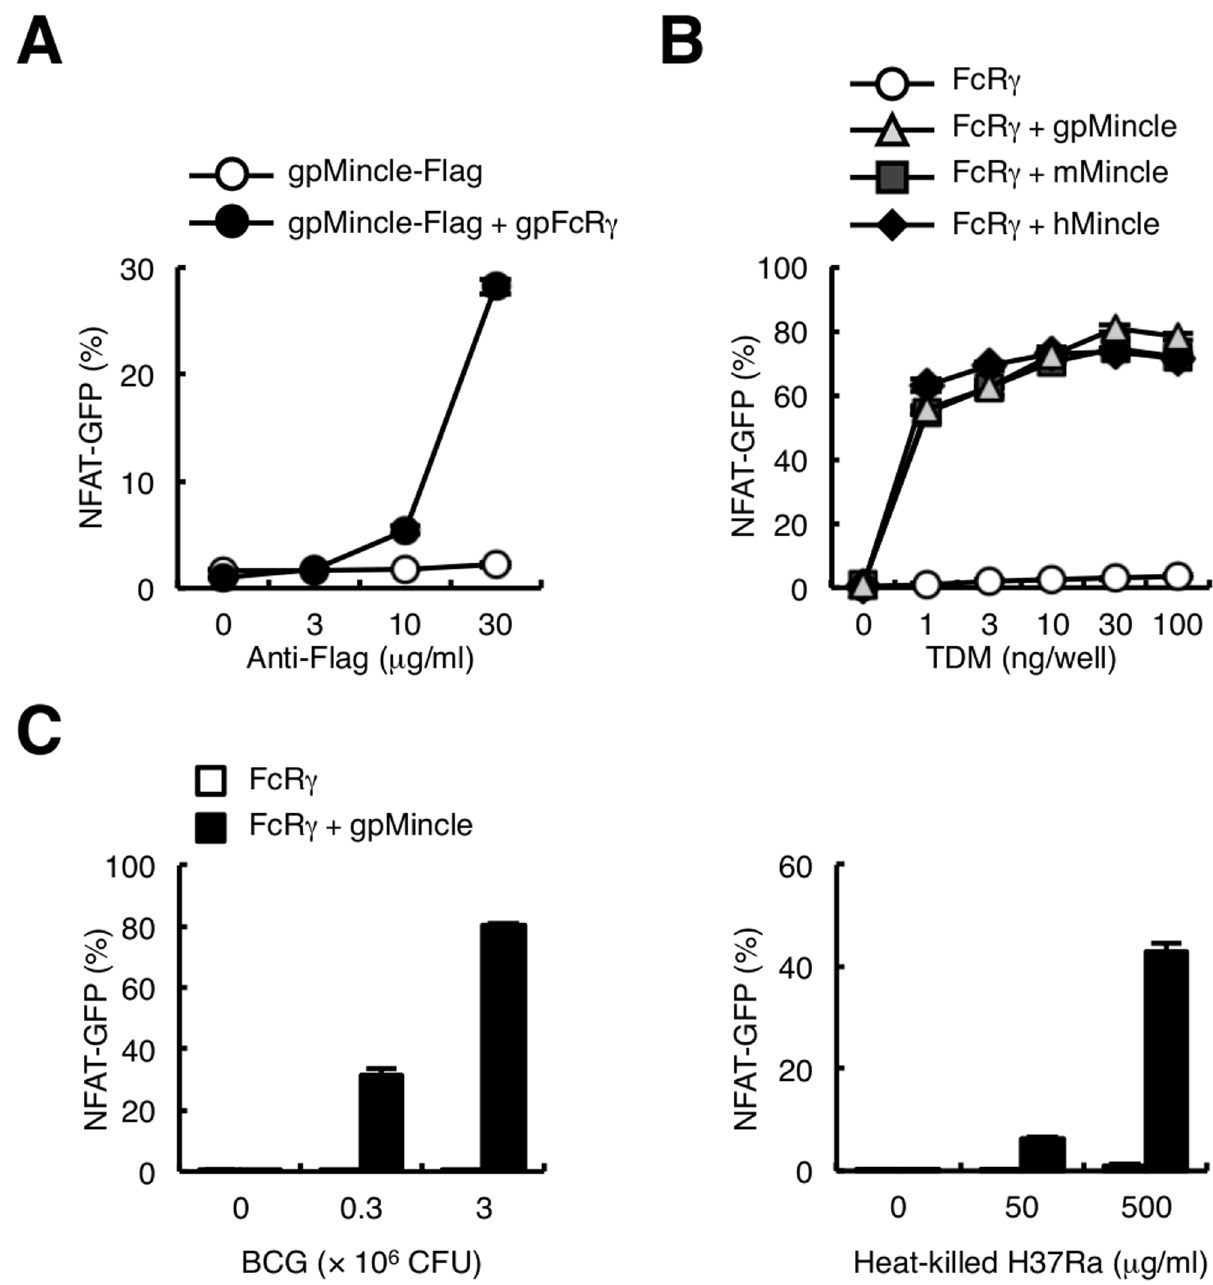
Figure 4. gpMincle functions as an activating receptor for TDM. (A) gpMincle transduces activation signal through gpFcR c . NFAT-GFP reporter cells were transfected with Flag-tagged gpMincle alone or together with gpFcR c . Reporter cells were stimulated with plate-coated anti-Flag mAb for 24 h. Induction of NFAT-GFP was analyzed by flow cytometry. (B) gpMincle is a TDM receptor. Indicated reporter cells were stimulated with plate-coated TDM for 24 h. Induction of NFAT-GFP was analyzed by flow cytometry. (C) gpMincle recognizes mycobacteria. Reporter cells were stimulated with M. bovis BCG (left panel) and heat-killed M. tuberculosis H37Ra (right panel) for 24 h. Induction of NFAT-GFP was analyzed by flow cytometry. Data are presented as mean 6 s.d. and representative of two or three separate